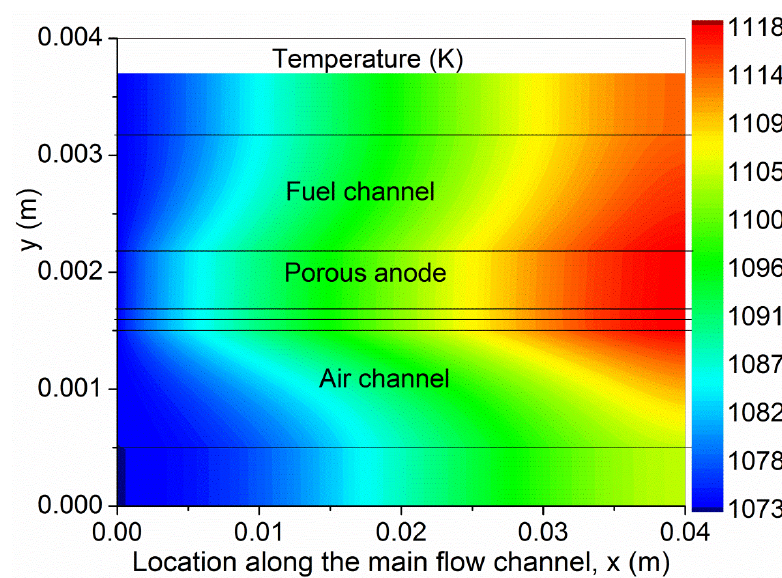
Figure 4. Temperature in SOFC.